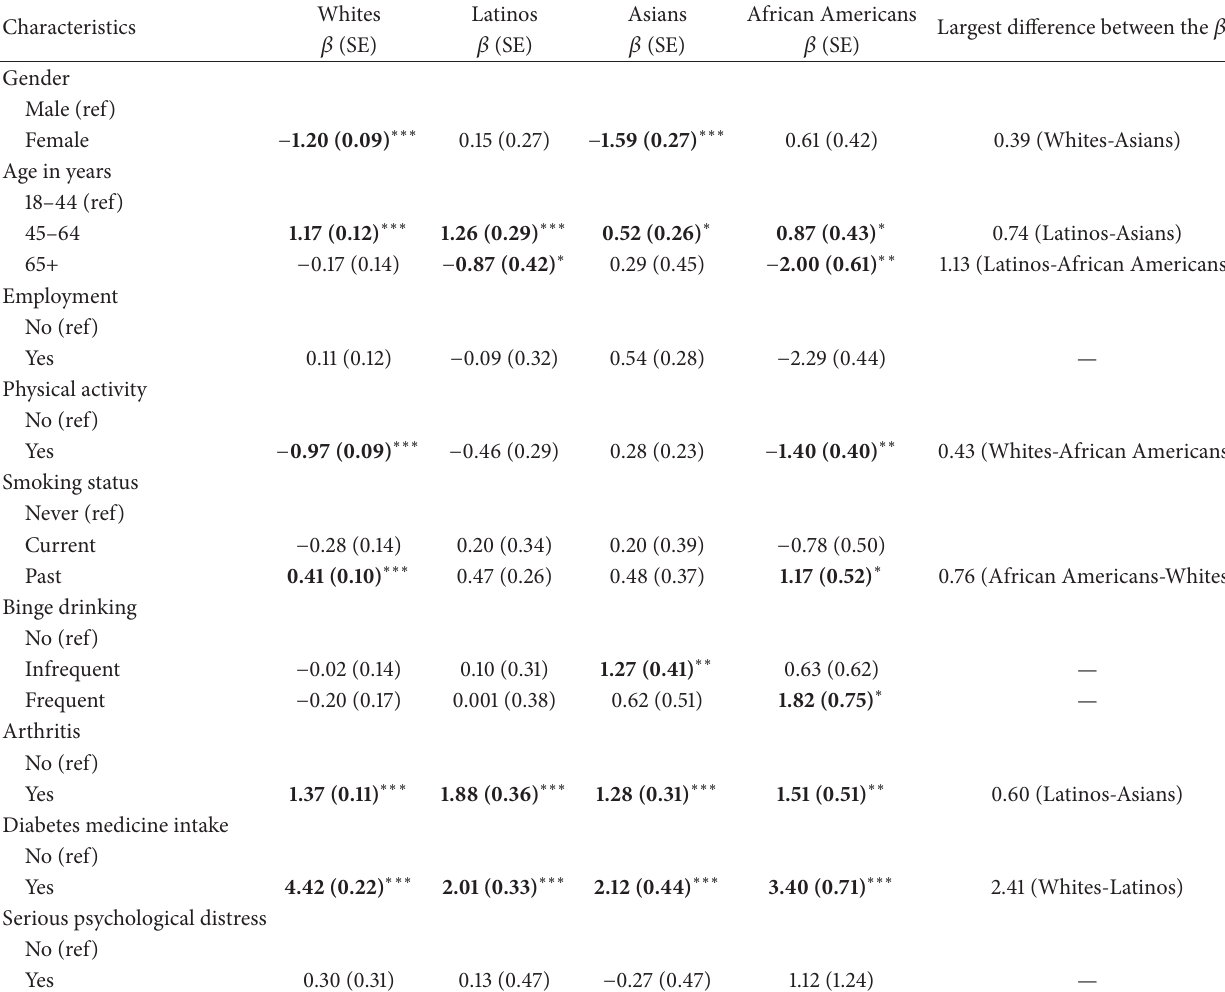
Table 4: Multiple linear regression analysis of ethnic differences in risk factors for body mass index